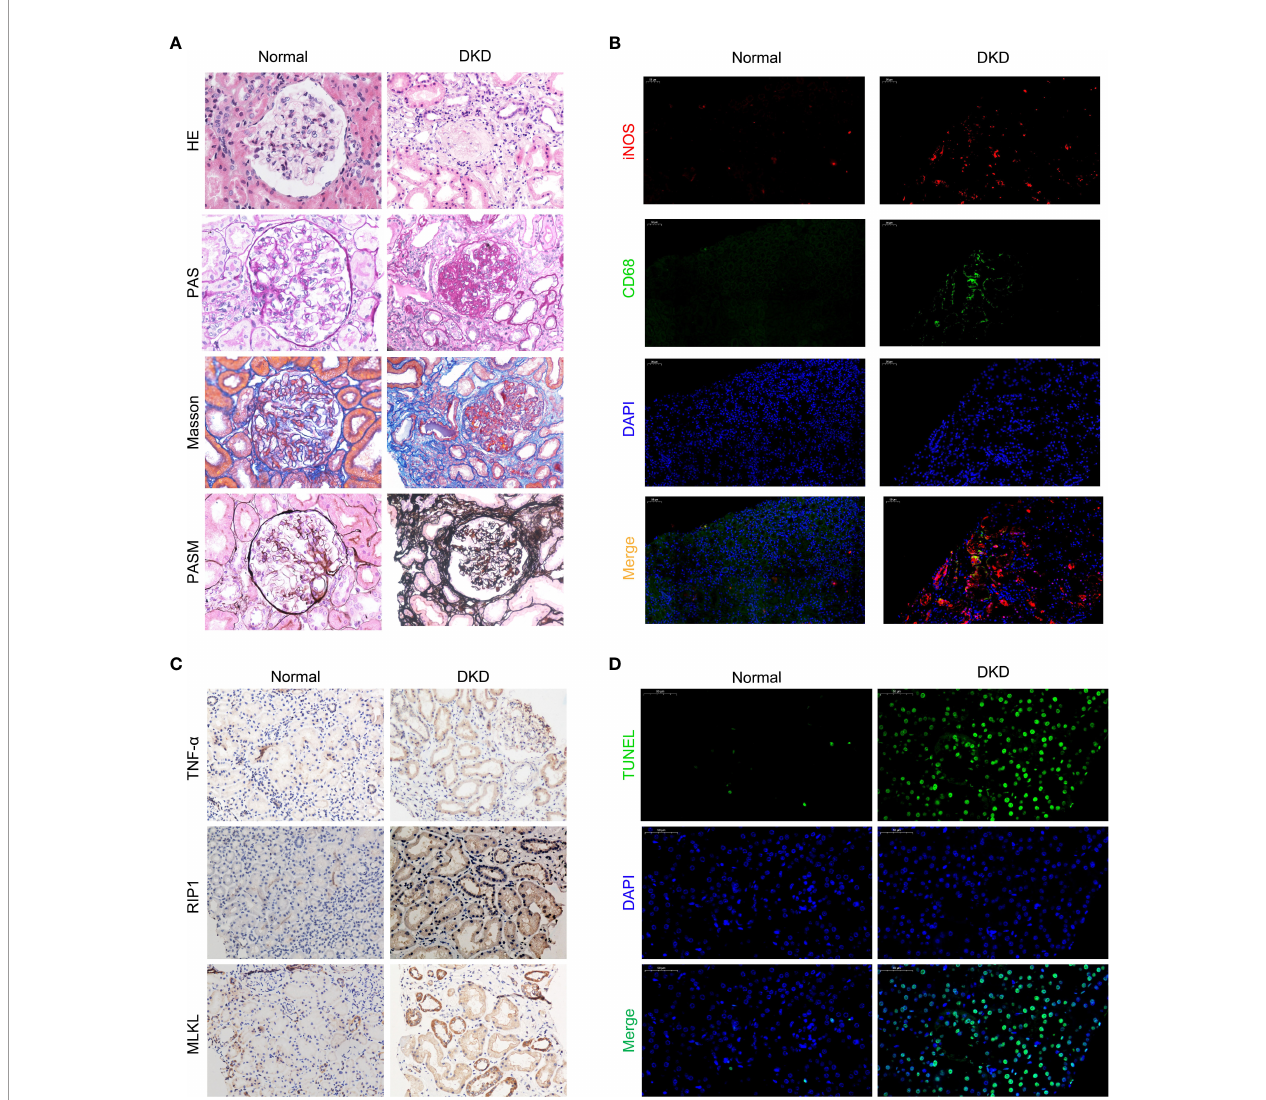
FIGURE 1 | Macrophages in fi ltrate the kidneys of patients with diabetic kidney disease and are closely related to cell death. (A) Staining of kidney specimens included hematoxylin-eosin staining (H-E), periodic acid-Schiff staining (PAS), Masson ’ s trichrome staining (Masson), and periodic acid-silver methenamine staining (PASM). Magni fi cation: ×400 (B) CD68/iNOS double immuno fl uorescence staining. Magni fi cation: ×200 (C) Immunohistochemistry of kidney samples. Magni fi cation: ×400. (D) TUNEL method to detect cell death in the kidney. Magni fi cation: ×400.Normal, normal control; DKD, diabetic kidney